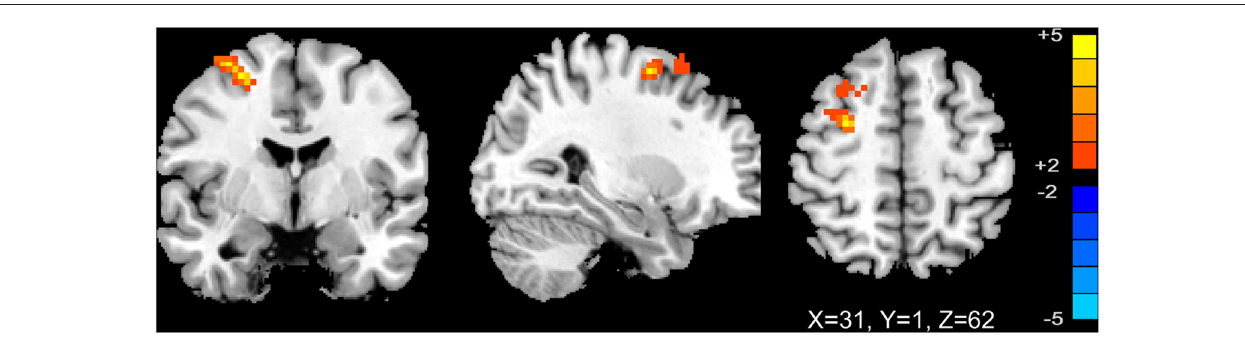
FIGURE 3 | T-map of group-level sensory-motor network connectivity in ST(+) and ST( − ) patients ( p < 0.01, AlphaSim corrected). ST(+) patients demonstrated higher connectivity in right premotor cortex (superior frontal gyrus and middle frontal gyrus BA 6).